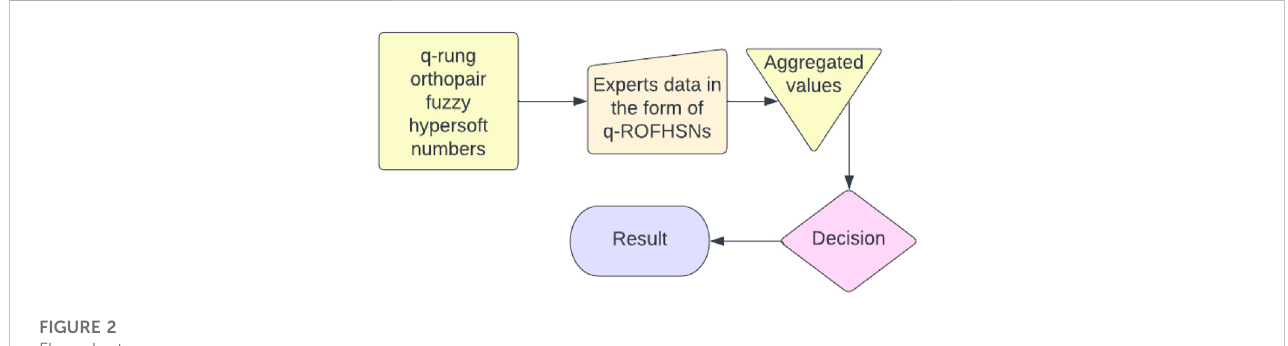
FIGURE 2 Flow chart.